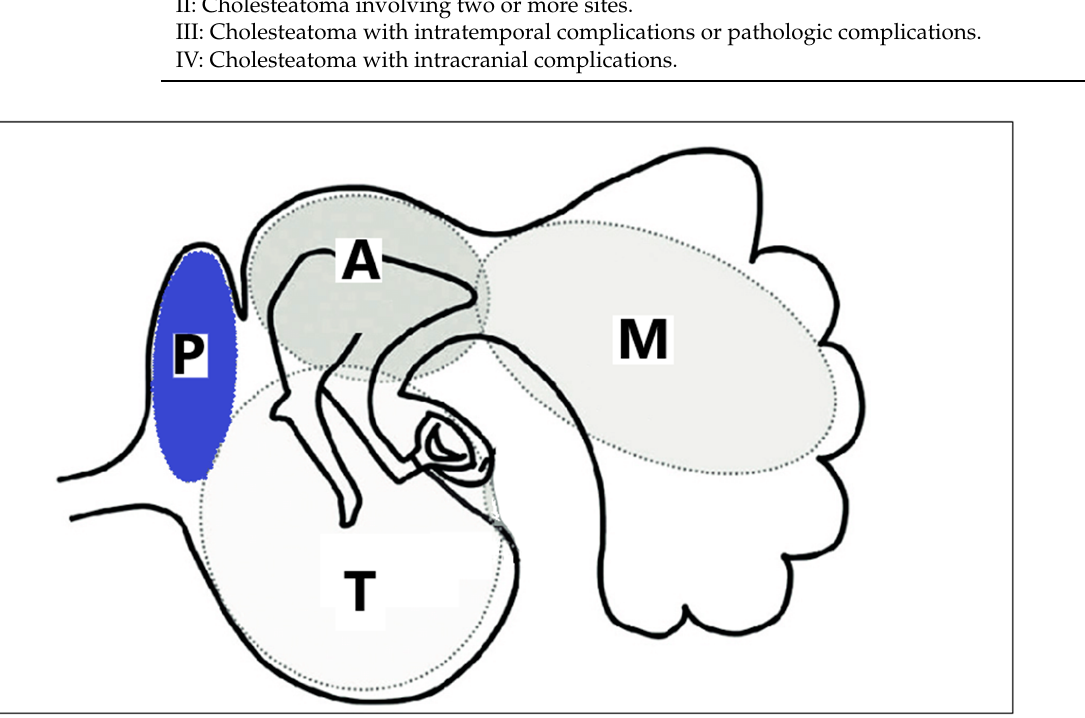
Figure 1. Schematic drawing of divisions of the tympanomastoid space. The tympanomastoid space is divided into four sections of the protympanum (P), the tympanic cavity (T), the attic (A), and the mastoid (M) in order to represent the extent of cholesteatoma (adapted from Tetsuya Tono et al., 2017 [1]).